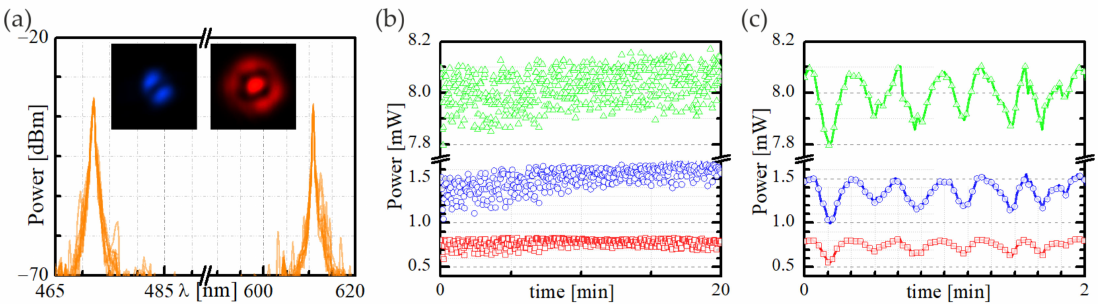
Figure 6. A close-up view of the spectral characteristics of the Stokes and anti-Stokes beams generated in the IM-FWM process in FUT of a winding diameter: ( a , b ) ϕ = 30 mm and ( c , d ) ϕ = 20 mm, for the pump polarization of 0 ◦ , 45 ◦ , and 90 ◦ (blue, gray, and orange lines, respectively). The insets present the Stokes/anti-Stokes modal profiles for the pump polarization: ( a , b ) 45 ◦ and ( c , d ) 90 ◦ ; ( e ) the Stokes (red circles) and anti-Stokes (blue squares) beams’ power and ( f ) efficiency of the IM-FWM process that corresponds to ( c , d ), plotted for the pump beam power of 8.0 mW.